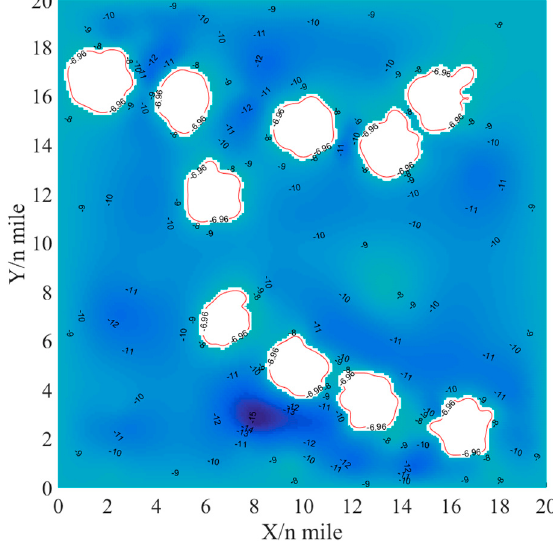
Figure 9. The schematic of navigable map. ( a ) Topographic map. ( b ) Contour map. ( c ) Navigable map.